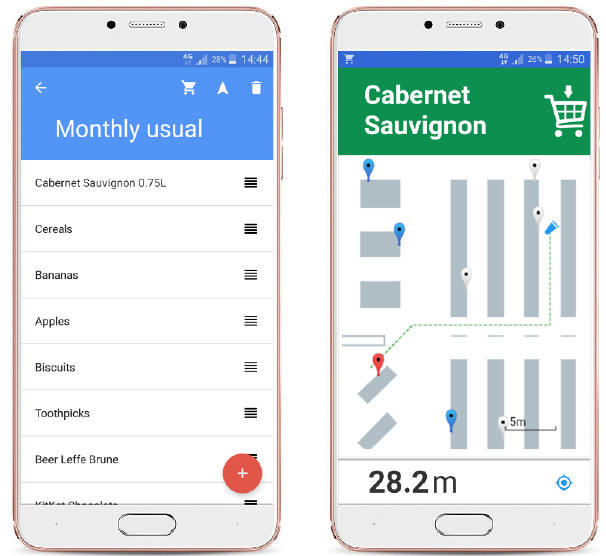
Figure 13. Mobile application screenshots. Shopping list editor screen on the left and the navigation screen on the right. The dotted line on the navigation screen represents the shortest path on the aisles graph from the current estimated cart location to the location of the next product in the shopping list. The more detailed view of the corresponding aisles graph is presented in Figure 11.